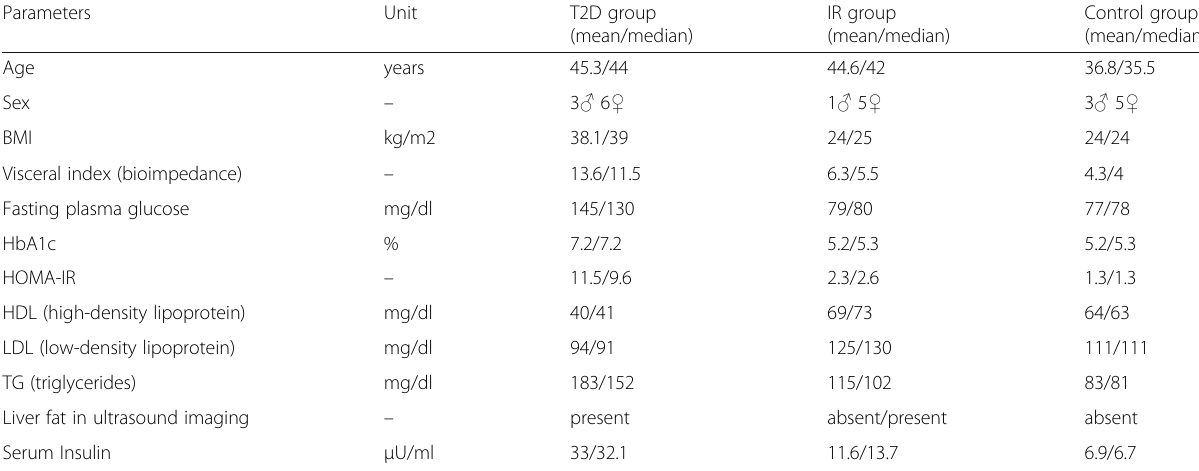
Table 1 Characteristic s of metabolic parameters